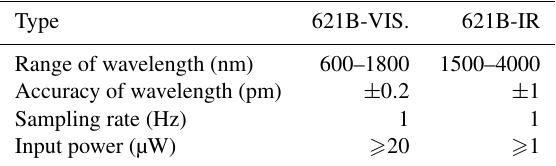
Table 3. Summary of the wavemeter parameters.